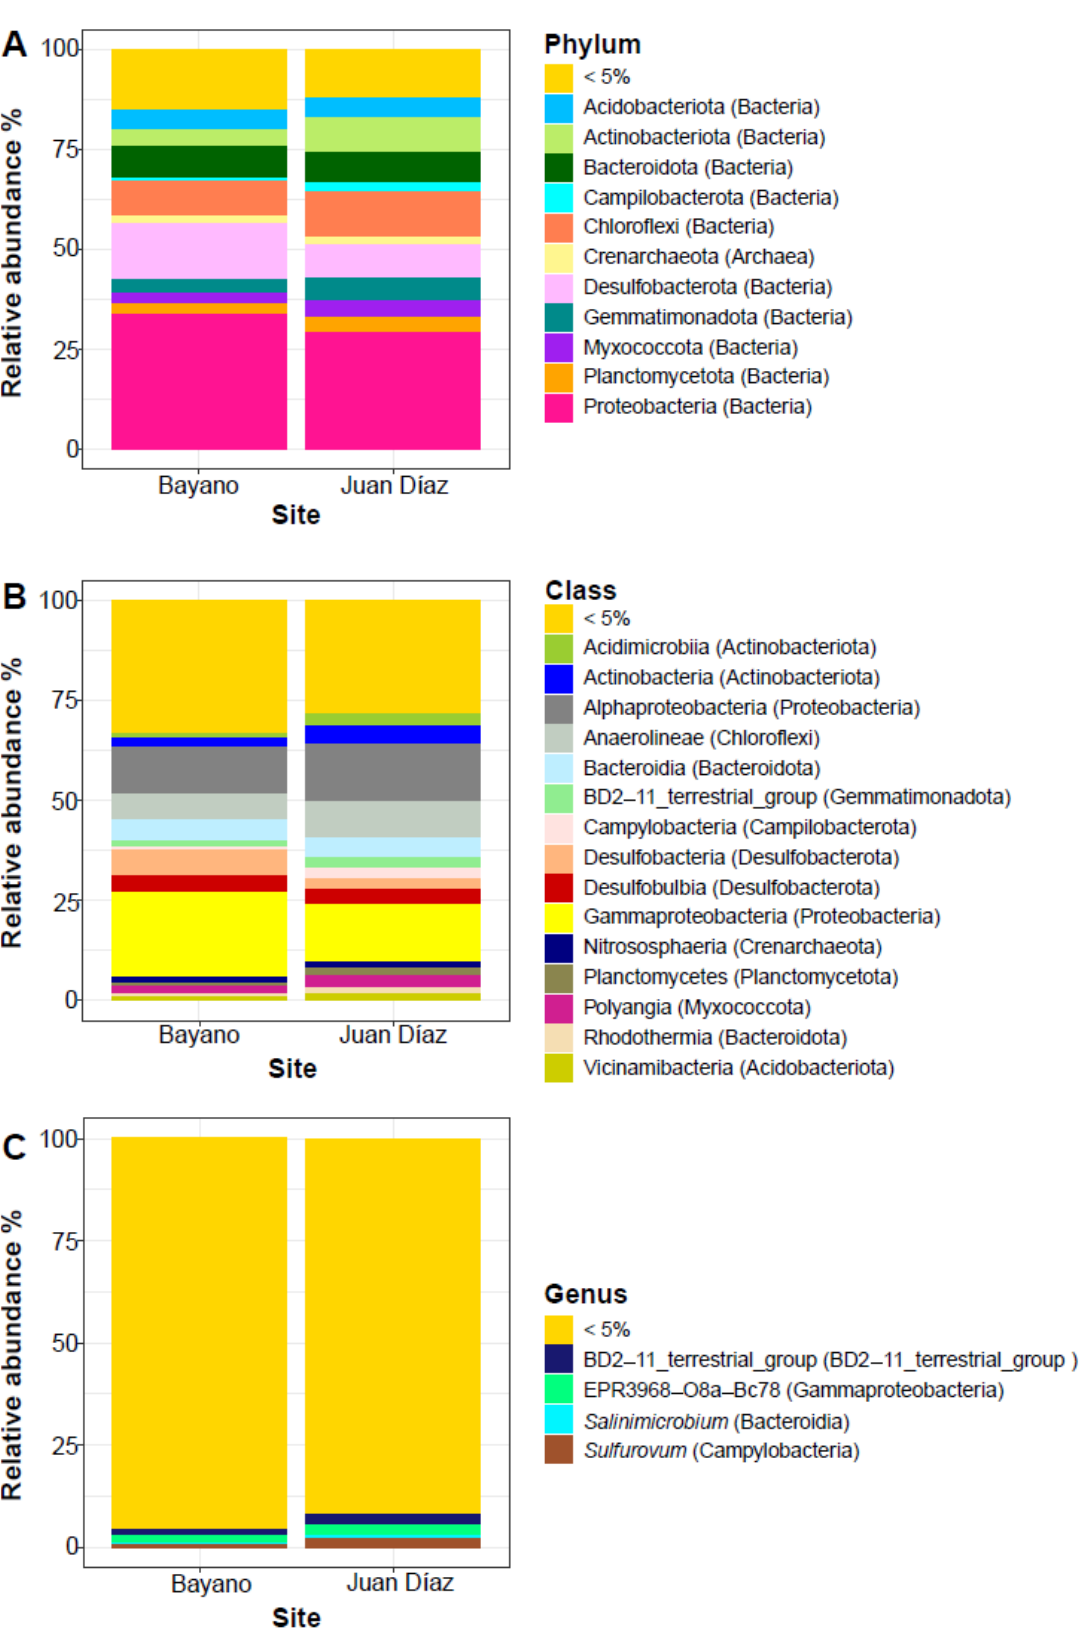
Figure 2. Relative abundance of the most common bacterial taxa associated with both Bayano and Juan Díaz mangrove sites. Abundance was estimated at the rank of phylum ( A ), class ( B ), and genus ( C ).